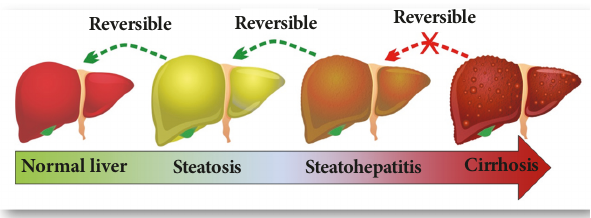
Figure 2: The progression of nonalcoholic fatty liver disease